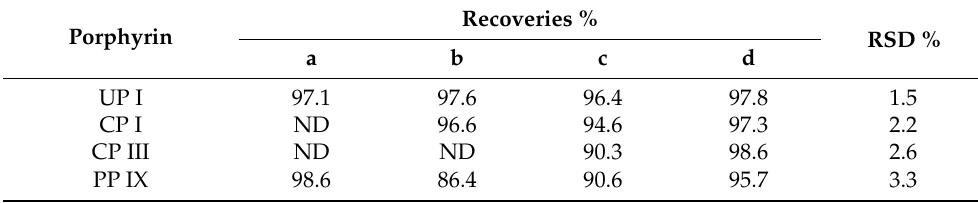
Table 5. Recoveries and RSD values of porphyrins in Southern flying squirrel